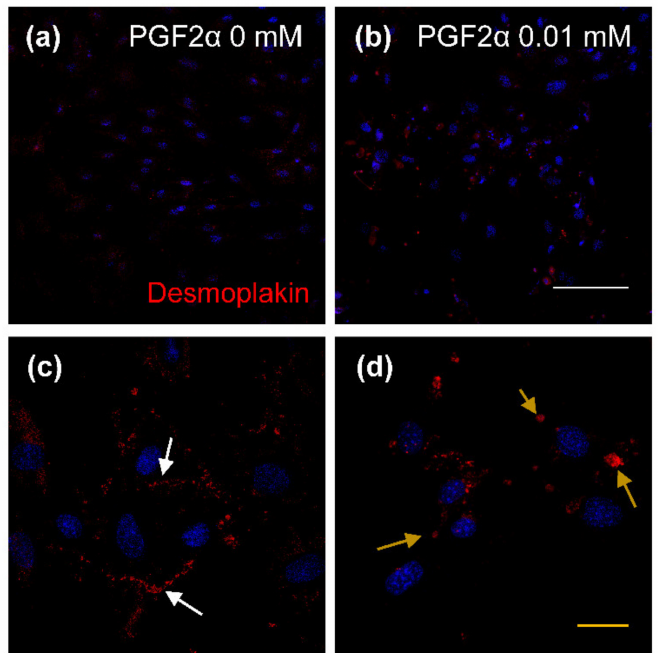
Figure 7. Expression of desmoplakin in prostaglandin F2 alpha (PGF2 α )-induced bovine luteal thecal cells (LTCs). The LTCs were observed using confocal laser scanning microscope. The LTCs were incubated with 0 mM ( a , c ) and 0.01 mM ( b , d ) PGF2 α for 24 h, white arrows: normal desmoplakin, yellow arrows: damaged desmoplakin, white line: 50 µ m, yellow line: 20 µ